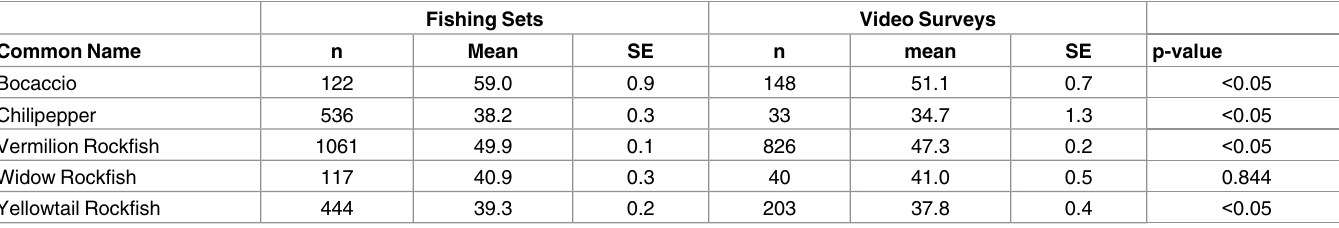
Table 8. Comparison of mean lengths of adult fishes in both video and fishing